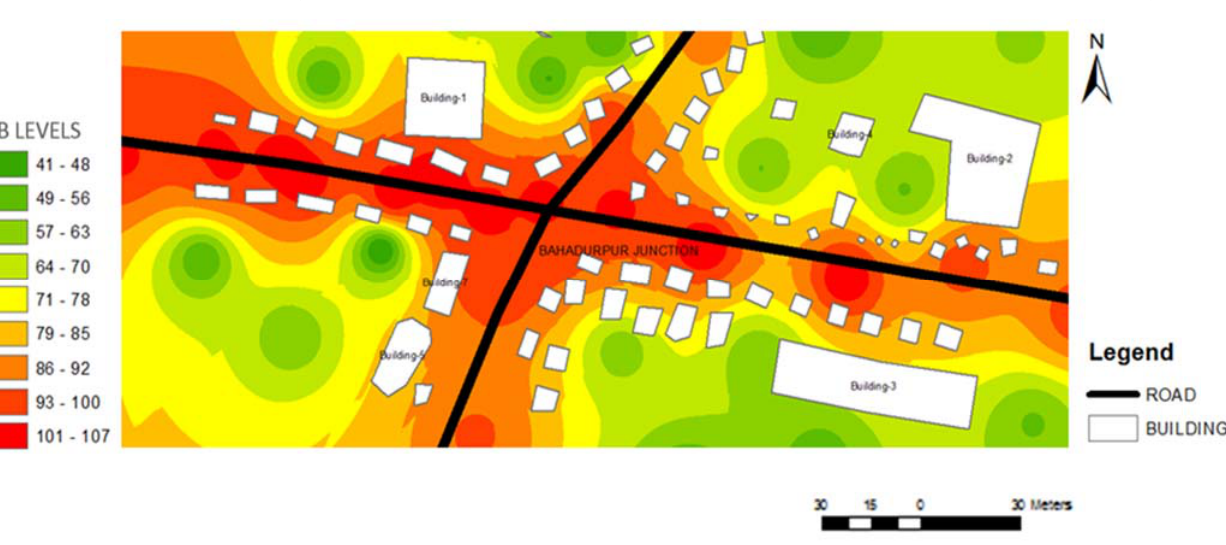
Figure 13. Various health hazards of noise exposure as reported in the literature.